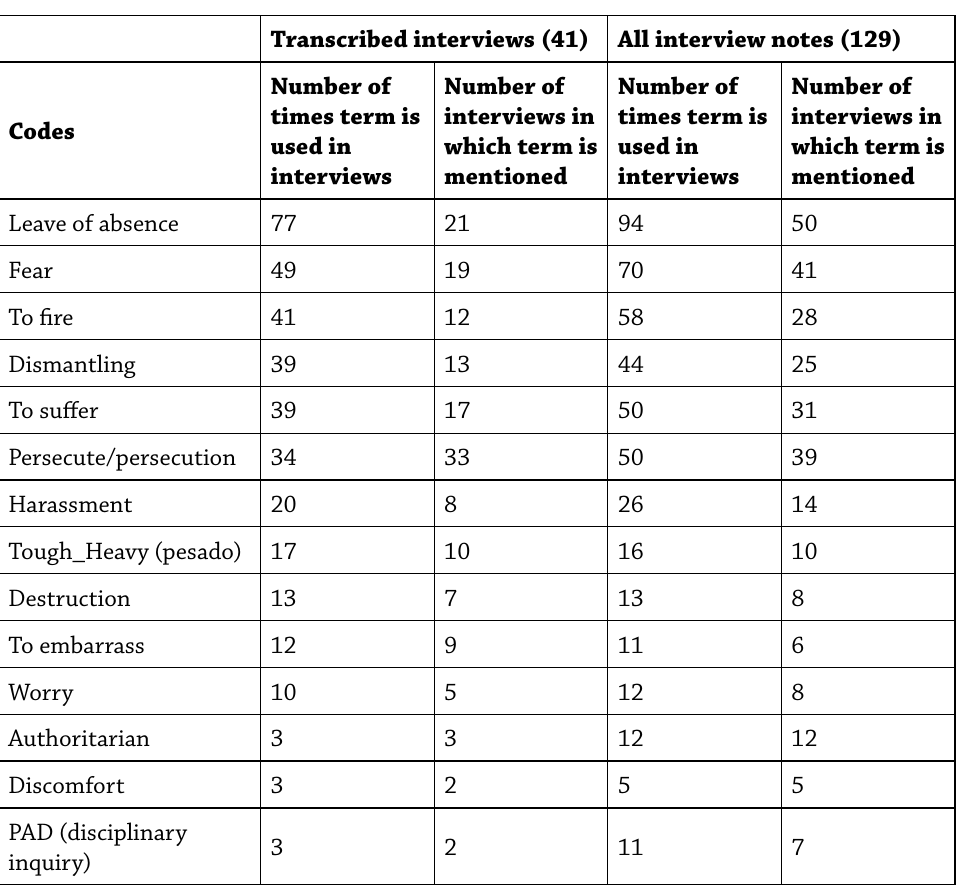
Table 5. Text queries of